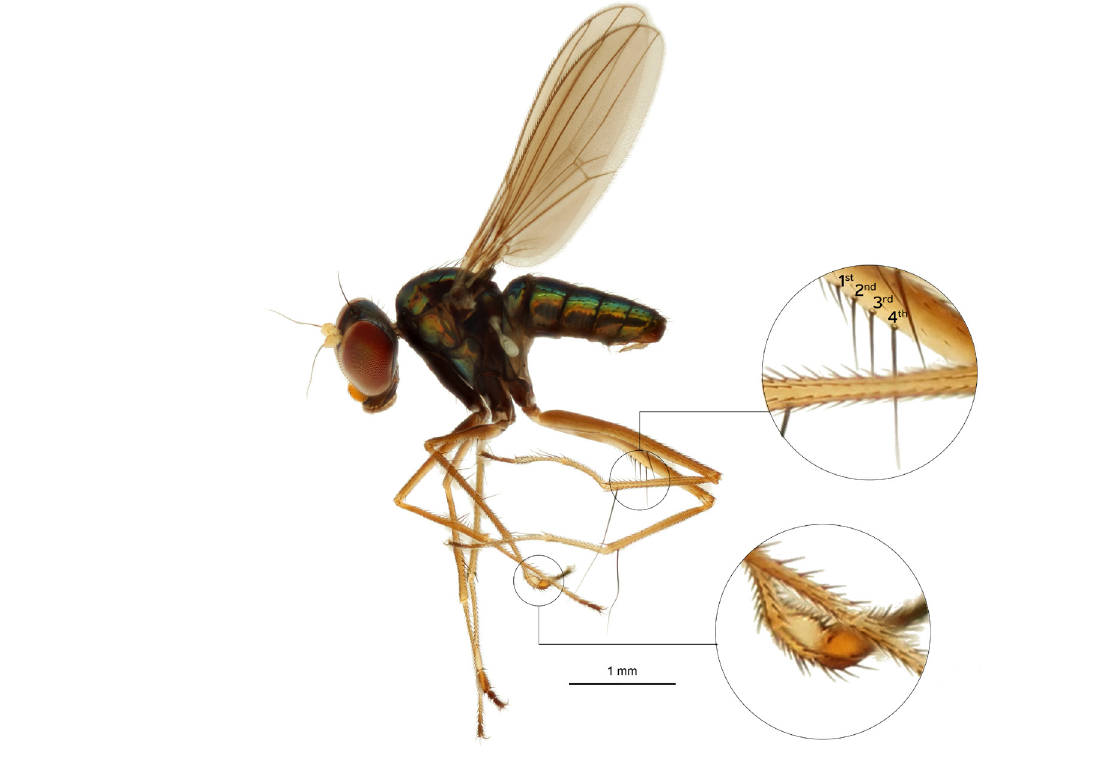
Fig. 8. Thinophilus subapicalis Samoh & Grootaert sp. nov. Male habitus (Abdulloh Samoh leg., PSUNHM